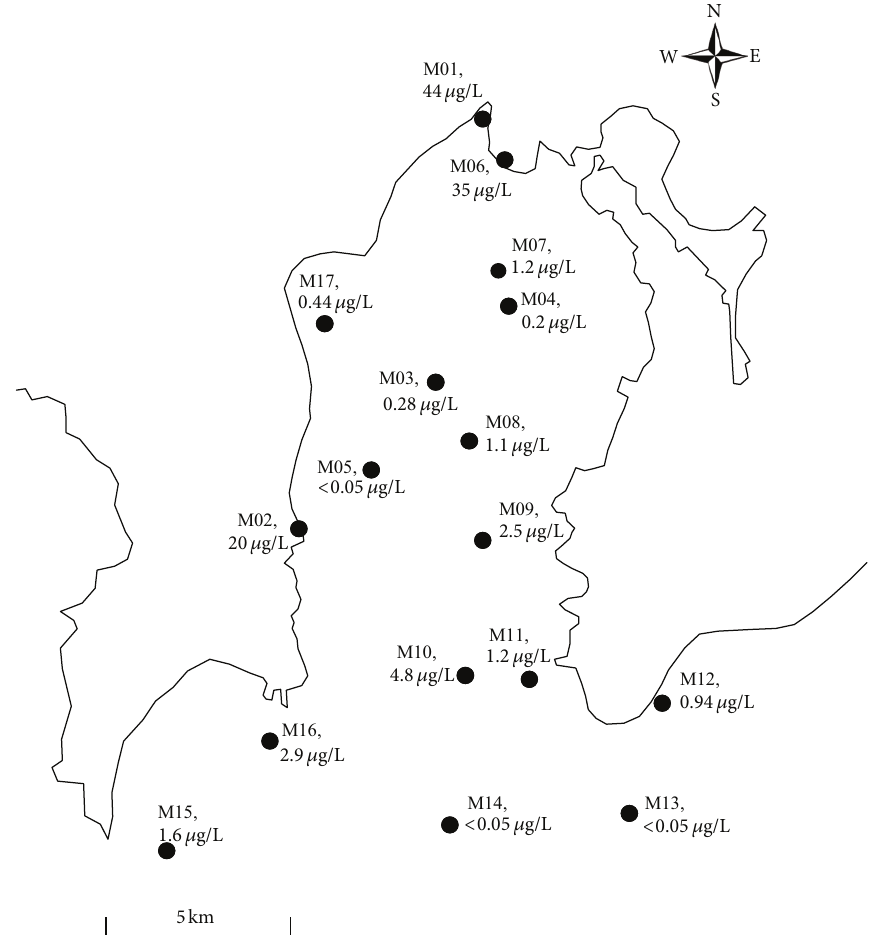
Figure 4: Microcystin distributions in Meiliang